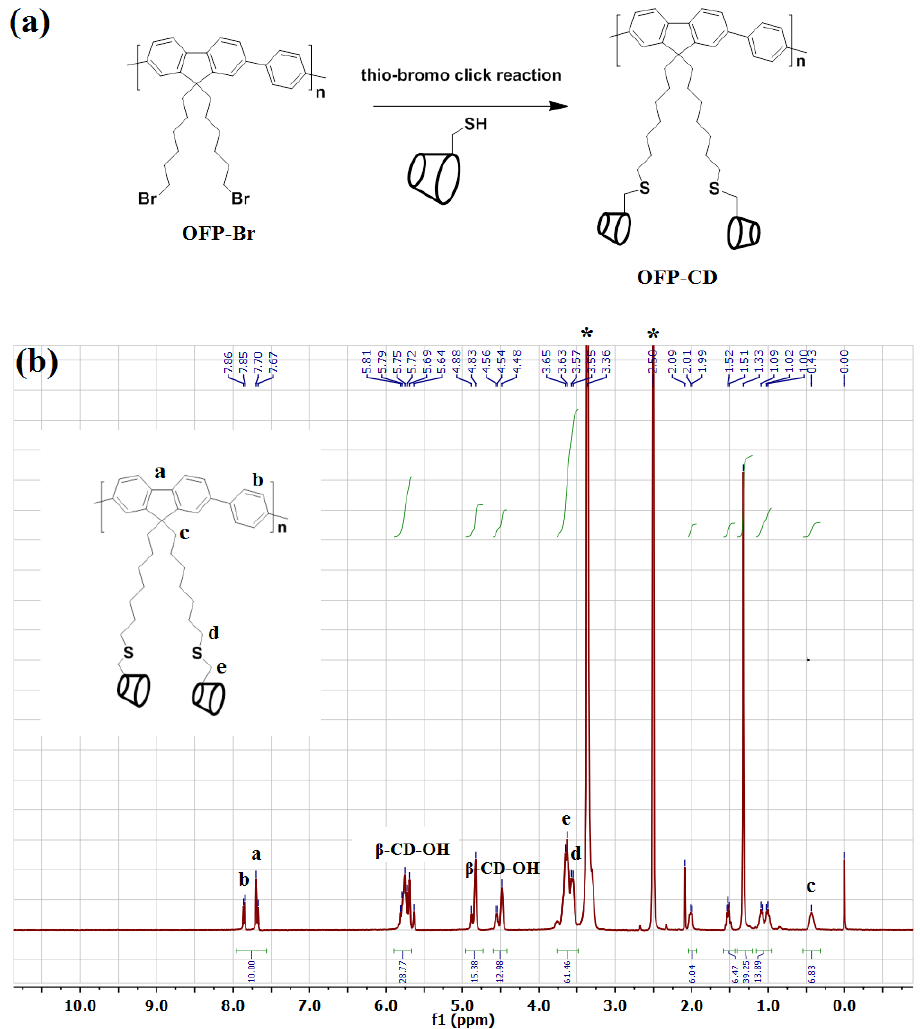
Figure 1. Synthesis of OFP-CD as the functional unit for sensor nanoarchitectonics. ( a ) Synthetic route for the preparation of OFP-CD. ( b ) 1 H-NMR spectrum of the obtained OFP-CD in DMSO- d 6 . *Indicates solvent residual peak of DMSO- d 6 at δ 2.5 and H 2 O at δ 3.36. The final glycoconjugated oligomer OFP-CD was therefore soluble in most polar sol- vents, such as DMSO, DMF, MeOH, and water. Investigations by 1 H-NMR analysis, along with labeling of chemical shifts (δ, ppm) , confirmed the molecular structure of OFP-CD (Figure 1b). Peaks originating from protons in the fluorene and aromatic units were ob- served at δ 7.6 7 – 7.86 ppm, while protons from S-CH 2 and O-CH 2 -S linkages were observed at δ 3.55 ppm, and δ 3.65 ppm, respectively. Finally, the protons arising from the backbone of β -CD units (labelled β -CD-OH on Figure 1b) were observed at δ 5.81, 4.88, and 4.54 ppm, respectively. Both the molecular weight and the polydispersity index of the oligo- mer OFP-CD were determined with GPC, using THF as eluent as 18200 Da with a PDI of 2.7. TEM images revealed that OFP-CD exhibit as spherical nanoparticles in water, with a size in the range of 150 – 200 nm, respectively (Figure 2).